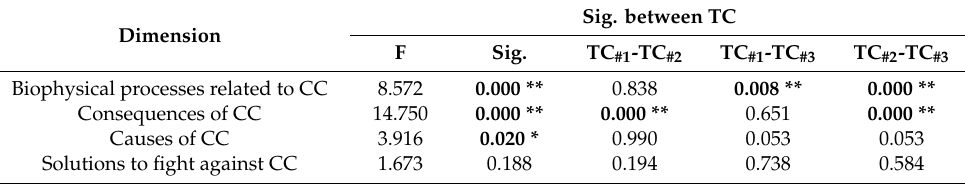
Table 8. Significant di ff erences by items of dimensions of CC and